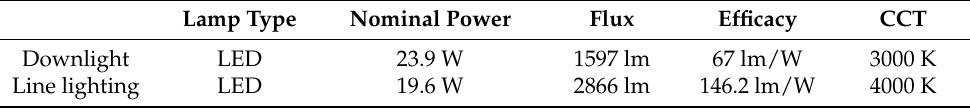
Table 7. Specifications of lighting fixtures.